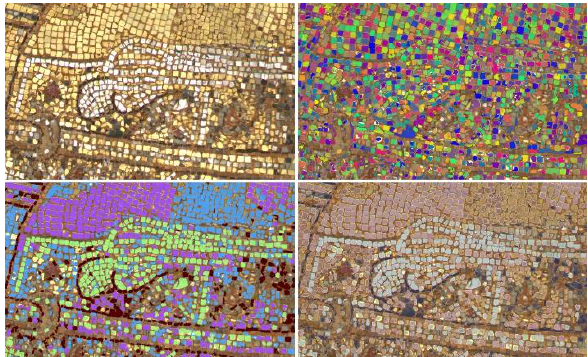
Figure 12 Segmentation, Classification and Semantization 4.